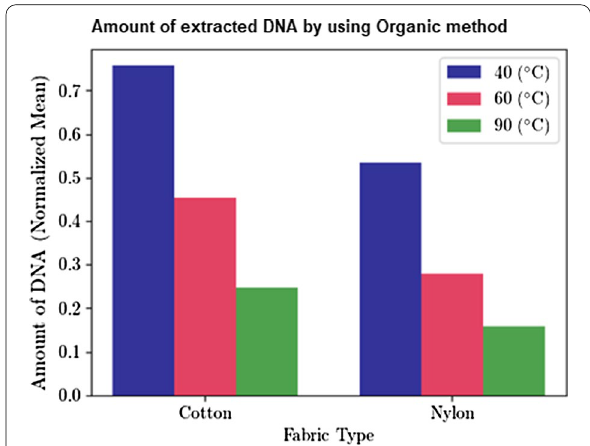
Fig. 12 Graphical representation of the amount of extracted DNA by using organic method